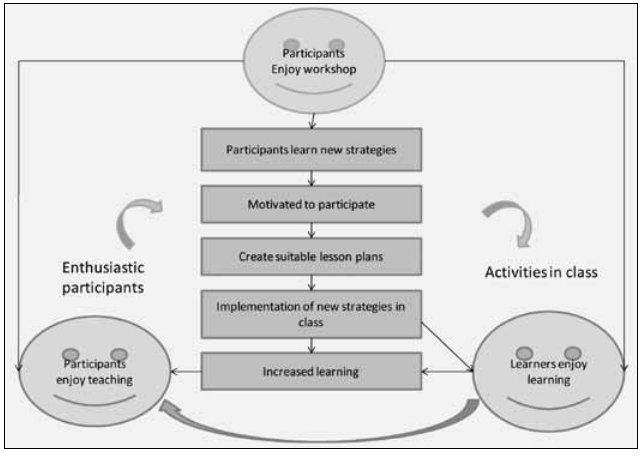
Fig. 3. The role of enjoyment in the